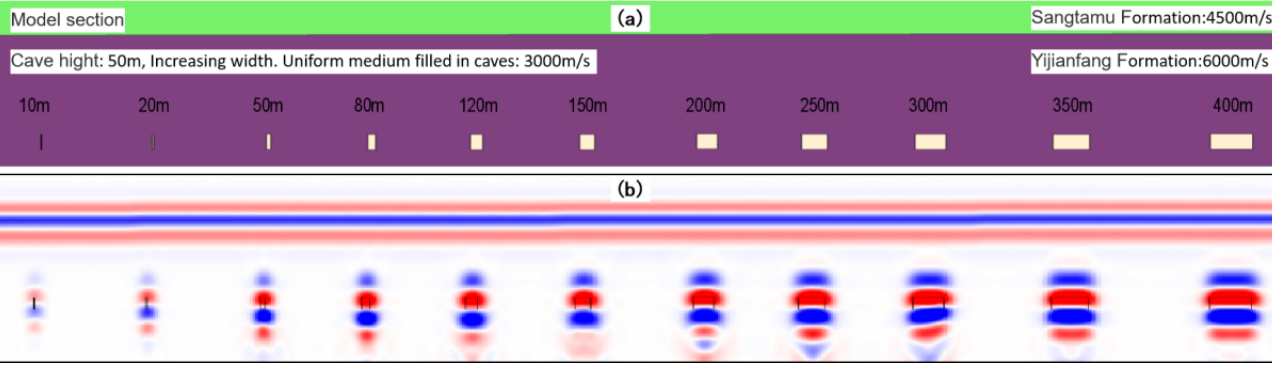
Figure 6. A geological model and forward modeling section of the cave reservoir. ( a ) cave reservoir geologic model and its parameters; ( b ) the profile of cave model superimposed on forward simula- tion